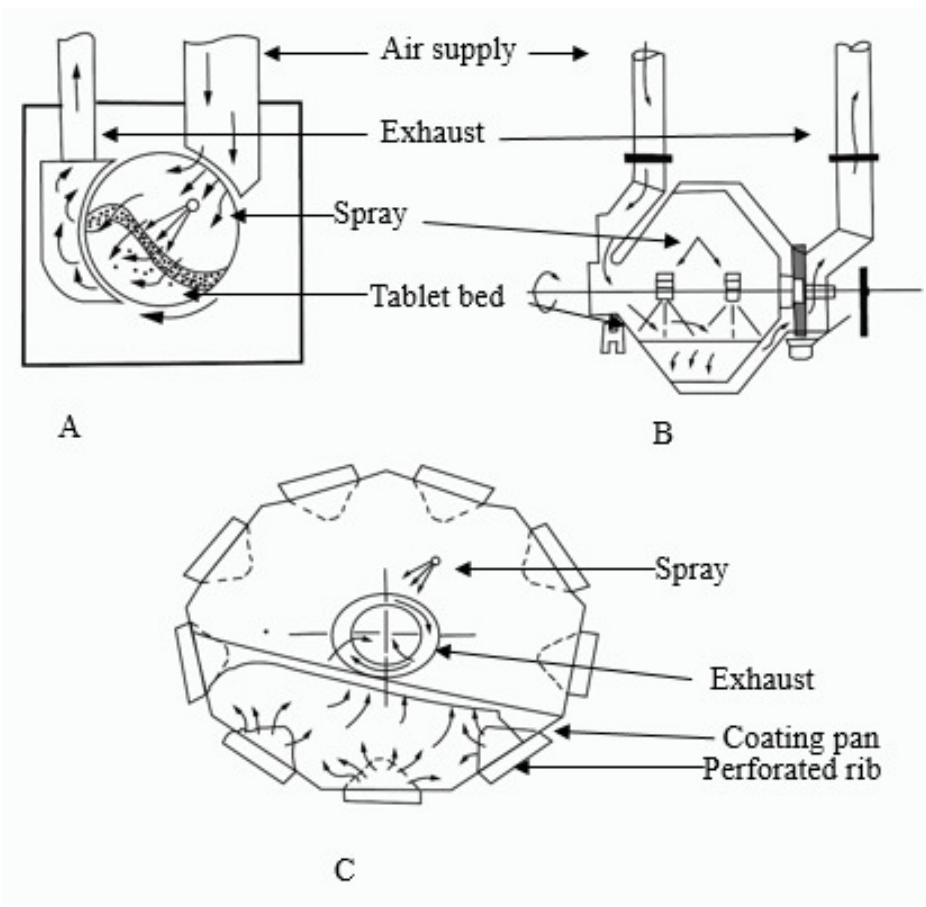
Figure 13. Represents ( A ) Acela coat system, ( B ) Hi coater system, and ( C ) Dria coater